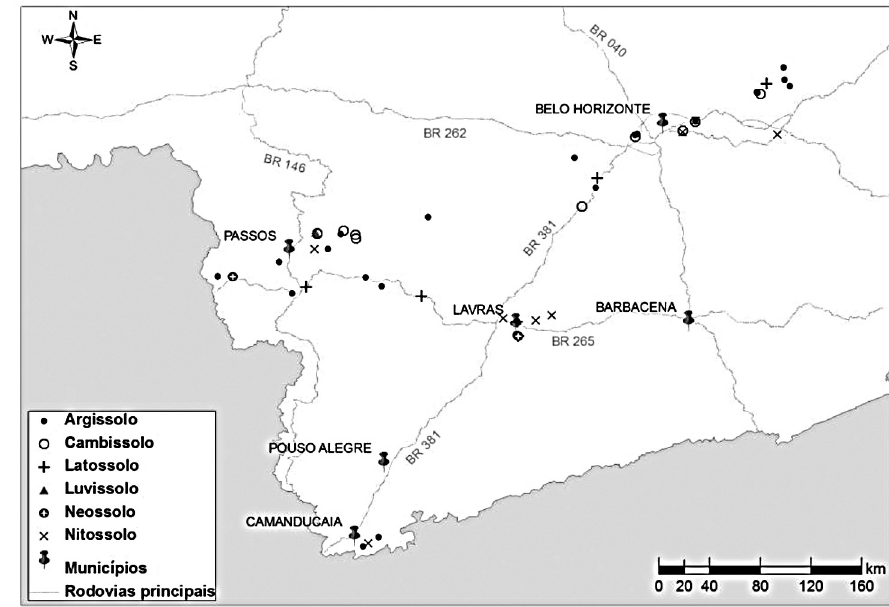
Figura 1. locais de amostragem de solo sob vegetação nativa em Minas